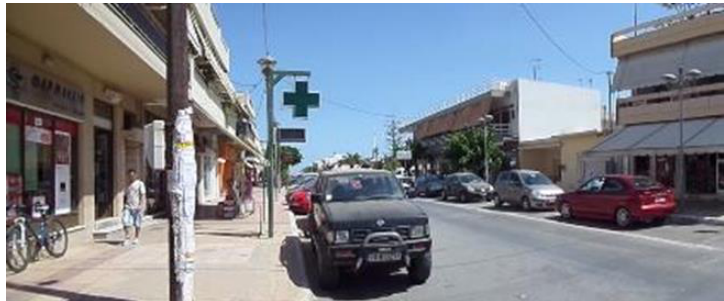
Figure 1. A typical urban road section at Alikarnassos district, Herakleio, island of Crete: the sound environment is mainly determined by road traffic, street morphology, materials, and human activities linked to shops and services.